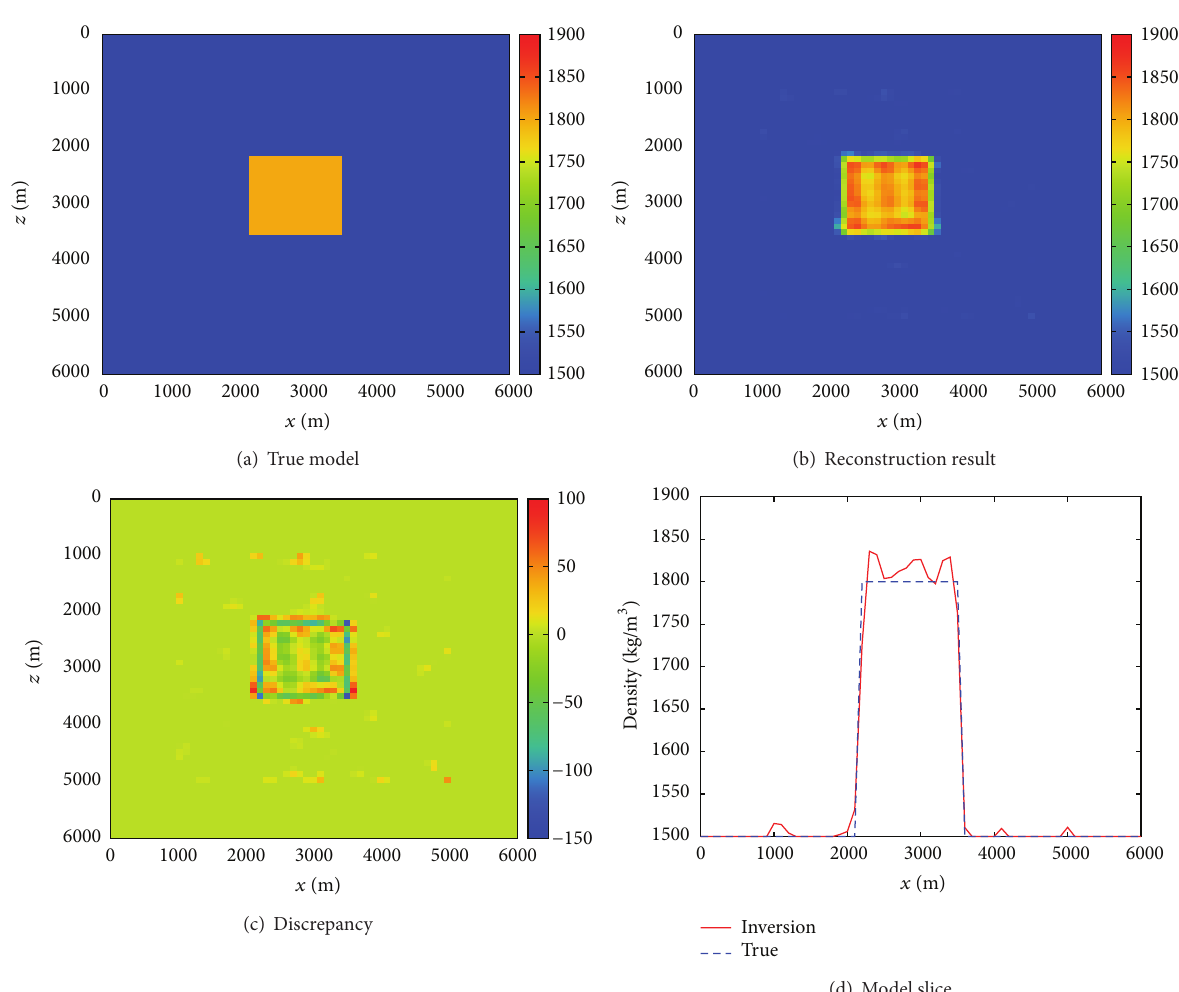
Figure 1: Applying the FD-MRCSI method to one abnormity inversion. (a) True model. (b) Reconstruction result after 1000 inversion iterations. (c) Discrepancy between true model and reconstruction result. (d) Slices at horizontal distances of 3 km for the true model and reconstruction